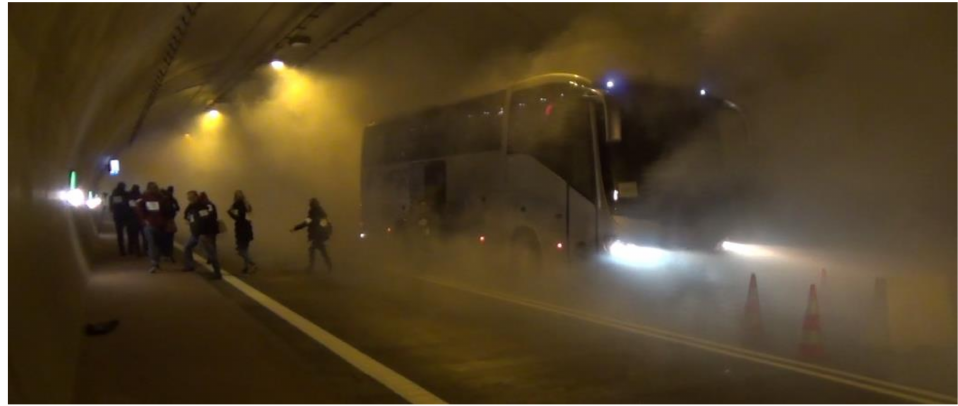
Figure 4. The selection of the evacuation route during experiment 1 in the Emilia tunnel in Laliki. Due to poor visibility, after leaving the vehicle, the participants formed organized groups. Each person probably saw only the person in front of him/her and followed that person. These self-organized groups left the tunnel heading towards the smoke, by selecting the nearest emergency exit, i.e., towards the source of the fire. The fact that participants in experiment 4 opted for the shortest evacuation route may be due to their losing their sense of direction as a result of the substantial accumulation of